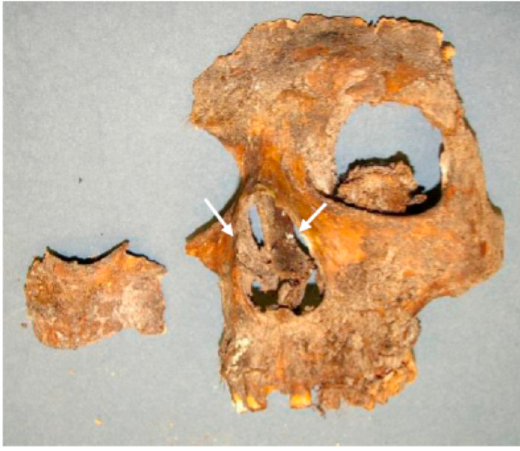
Figure 8. Discoloured bones of Brahe’s Apertura piriformis